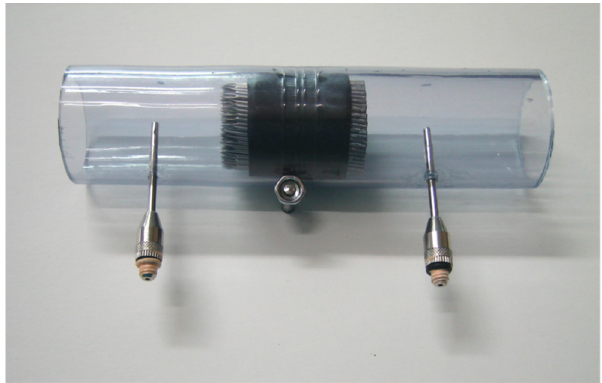
Figure 4. Photograph showing the complete Fleisch pneumotachograph.